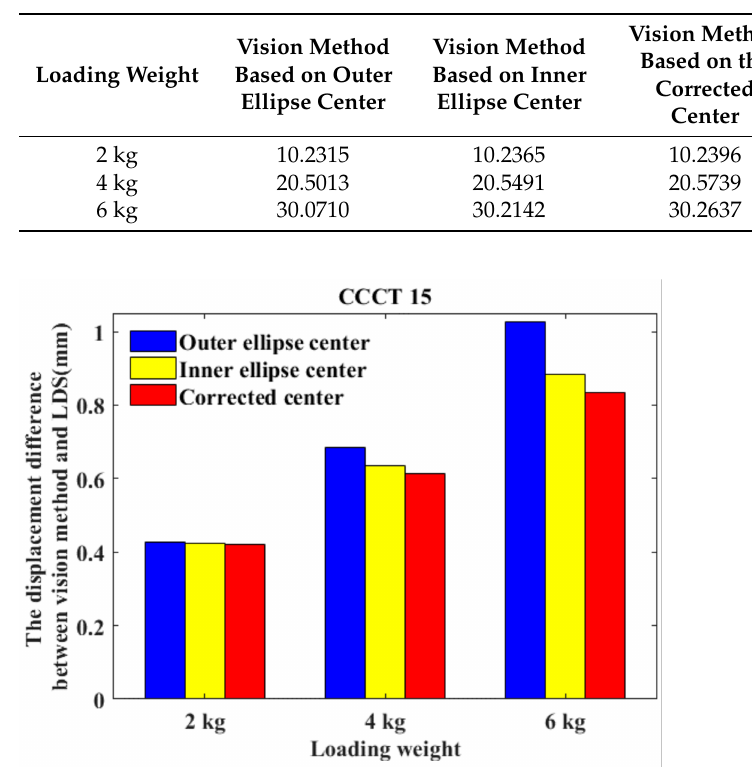
Figure 19. The displacement difference between vision method and laser displacement sensor (LDS) under different loading